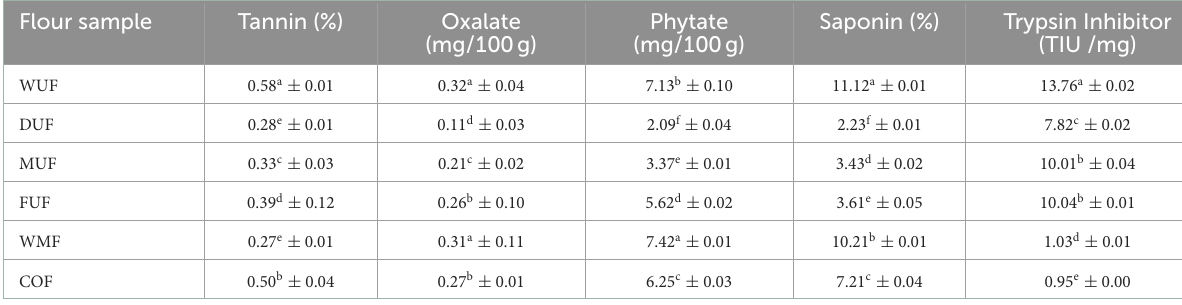
TABLE 1 Anti-nutrient content of whole, dehulled, malted, and defatted Ukwa flours, maize flour, and coconut grits. Flour sample Tannin (%) Oxalate